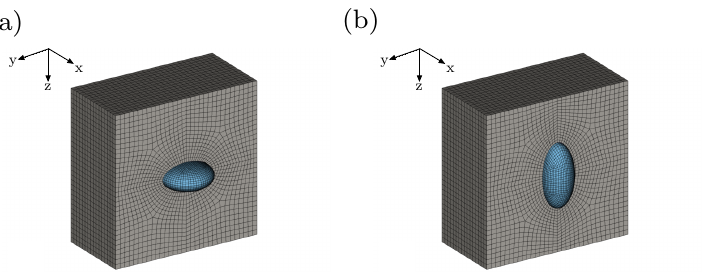
Figure 9. Finite element mesh of one half of the soft matrix and the whole inclusion with aspect ratio ( a ) r = 0.5 [ − ] and ( b ) r = 2.0 [ − ] , where f = 1%.